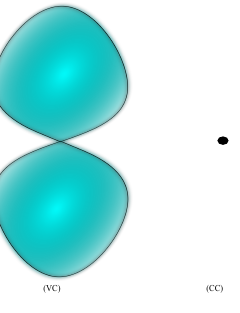
Figure 23. TI read by VC and CC at FML.